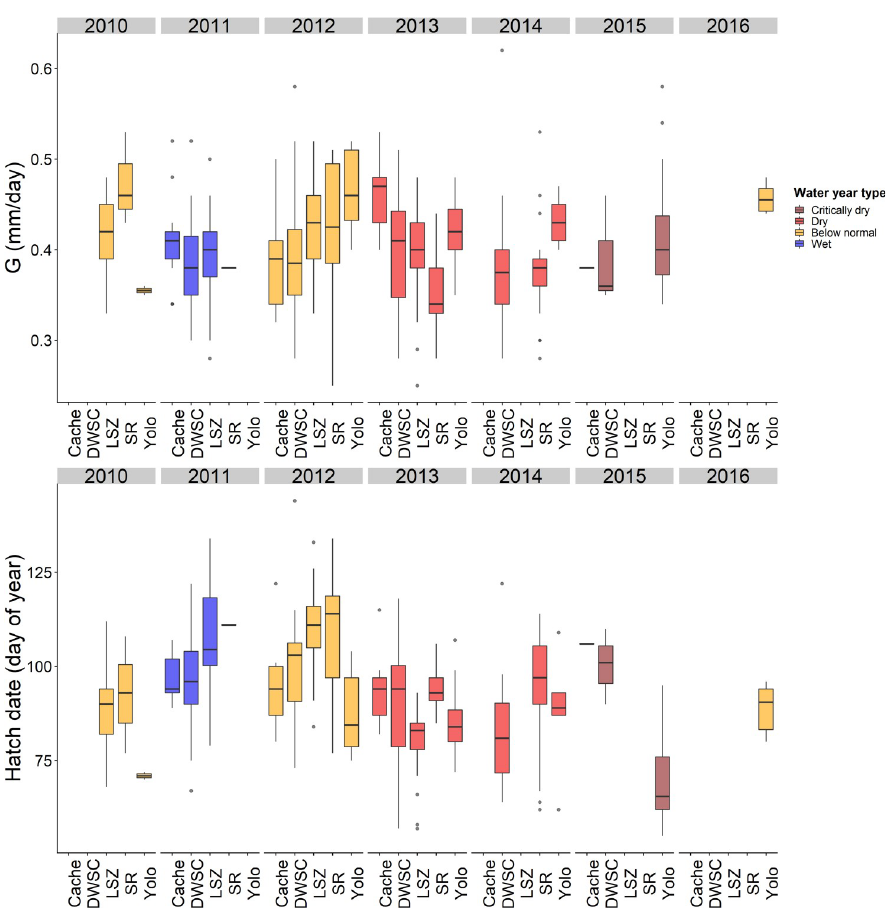
Fig 5. Box plots showing G (individual growth rate) and hatch date for juvenile Delta Smelt used in this study by region and year. Color indicates the water year classification for the year (e.g. critically dry, dry, wet, etc.). Region